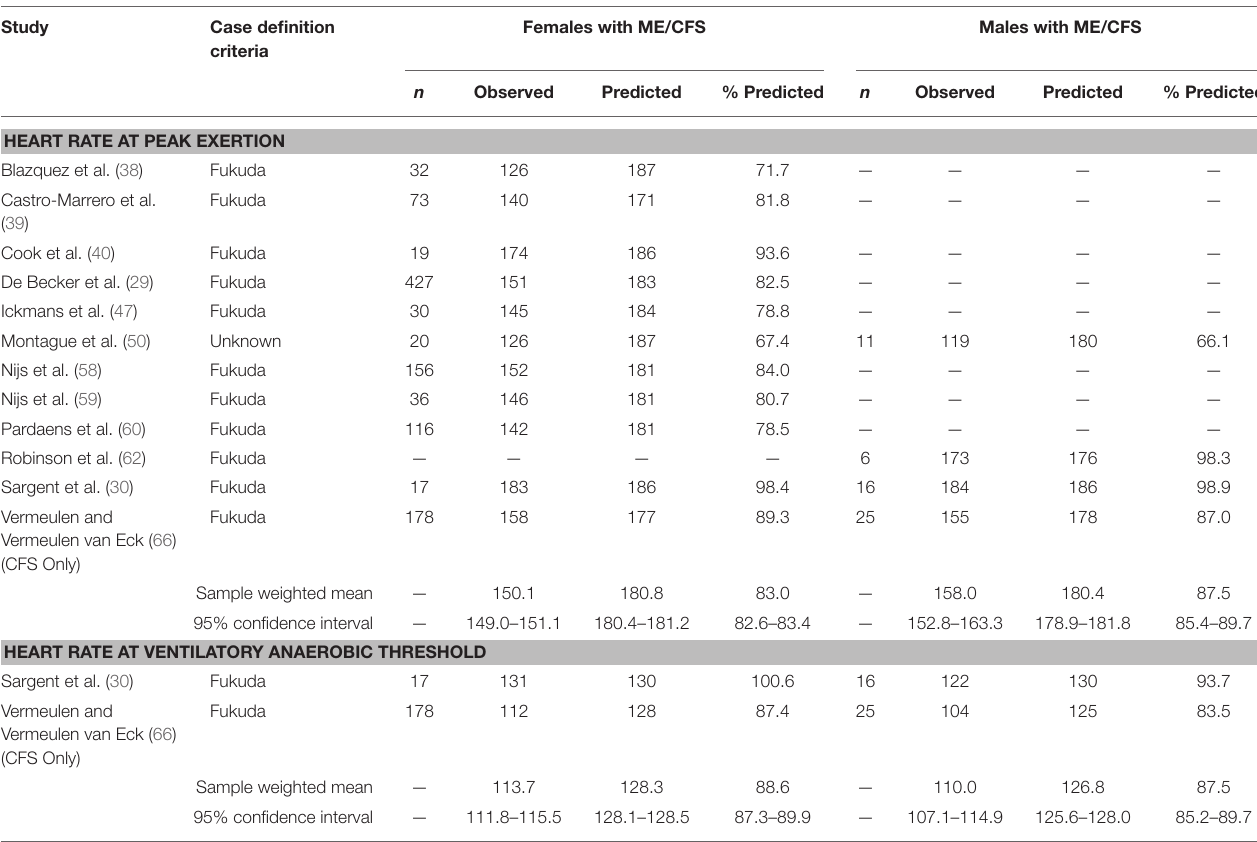
TABLE 3 | Heart rate measurements obtained at peak exertion and ventilatory anaerobic threshold during a single maximal cardiopulmonary exercise test in studies comparing females ( n = 1,104) and males ( n = 58) with myalgic encephalomyelitis/chronic fatigue syndrome.